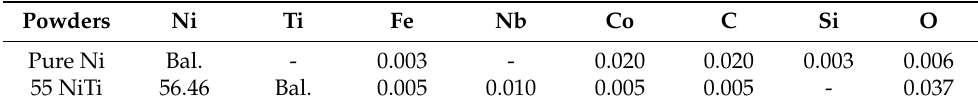
Table 1. Chemical composition of Ni and 55 NiTi powders (wt.%).